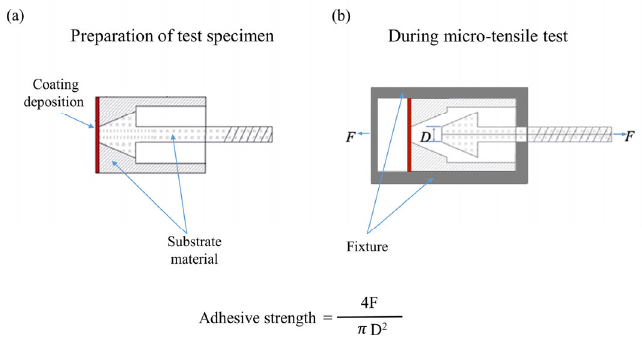
Figure 2. Schematic of the micro-tensile test: ( a ) coating is deposited on the test assembly made of substrate material, ( b ) micro-tensile test is carried out to pull the test assembly apart.